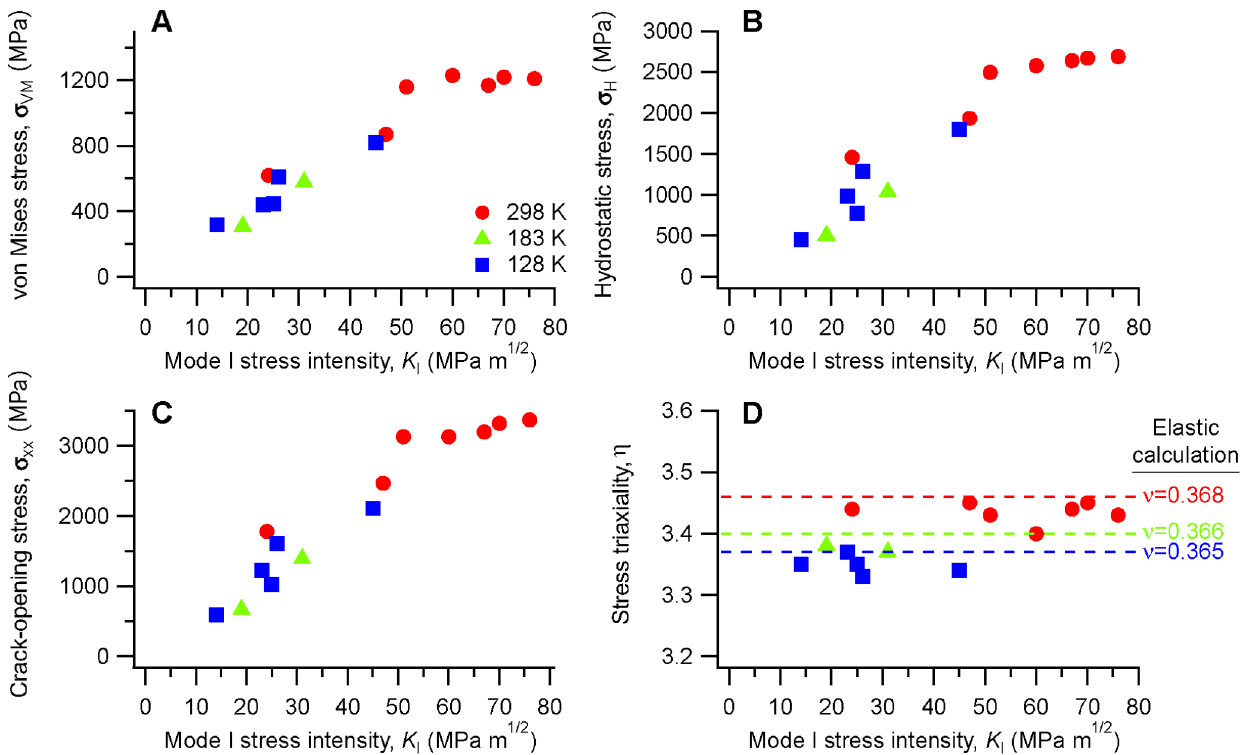
Figure 5. Trends in measured (a) maximum effective (von Mises) stress s VM , (b) mean (hydrostatic) stress s H , (c) crack-opening normal stress s xx , and (d) stress triaxiality g ( ~ s VM = s H ) as functions of stress intensity K I for multiple specimens at three temperatures. The dashed lines in (d) are the triaxialities calculated from the stress fields ahead of a crack tip in an elastic material under plane strain, using the values of n from Table 1 for the three temperatures.